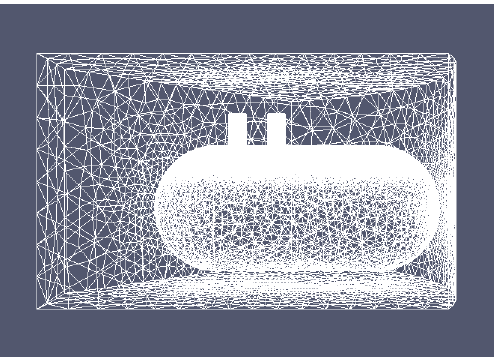
Figure 3. Overall simulation